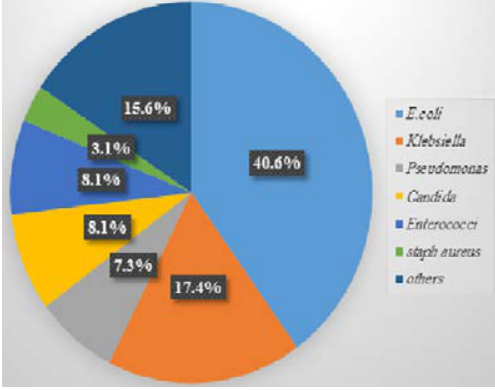
Fig. 1. Characterization of organisms isolated from urine